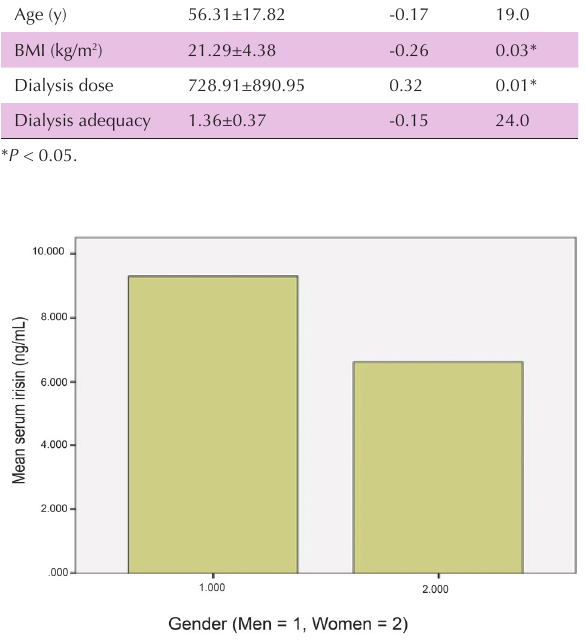
Figure 1. The correlation of irisin level and